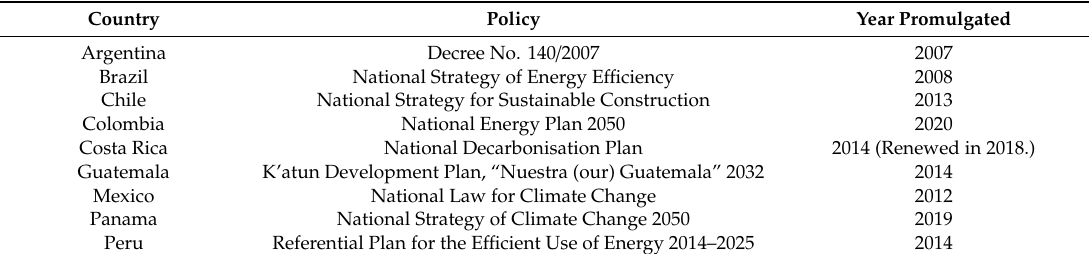
Table A2. Laws and decrees launched at the national level that induced the series of laws presented in this